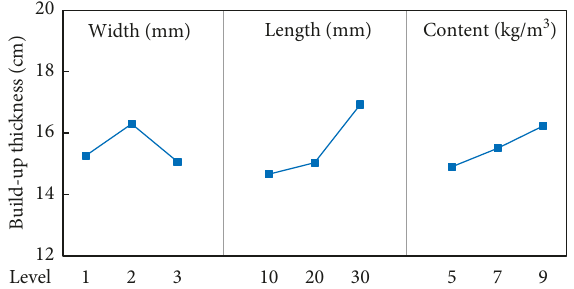
Figure 8: Main effect plot for build-up thickness.